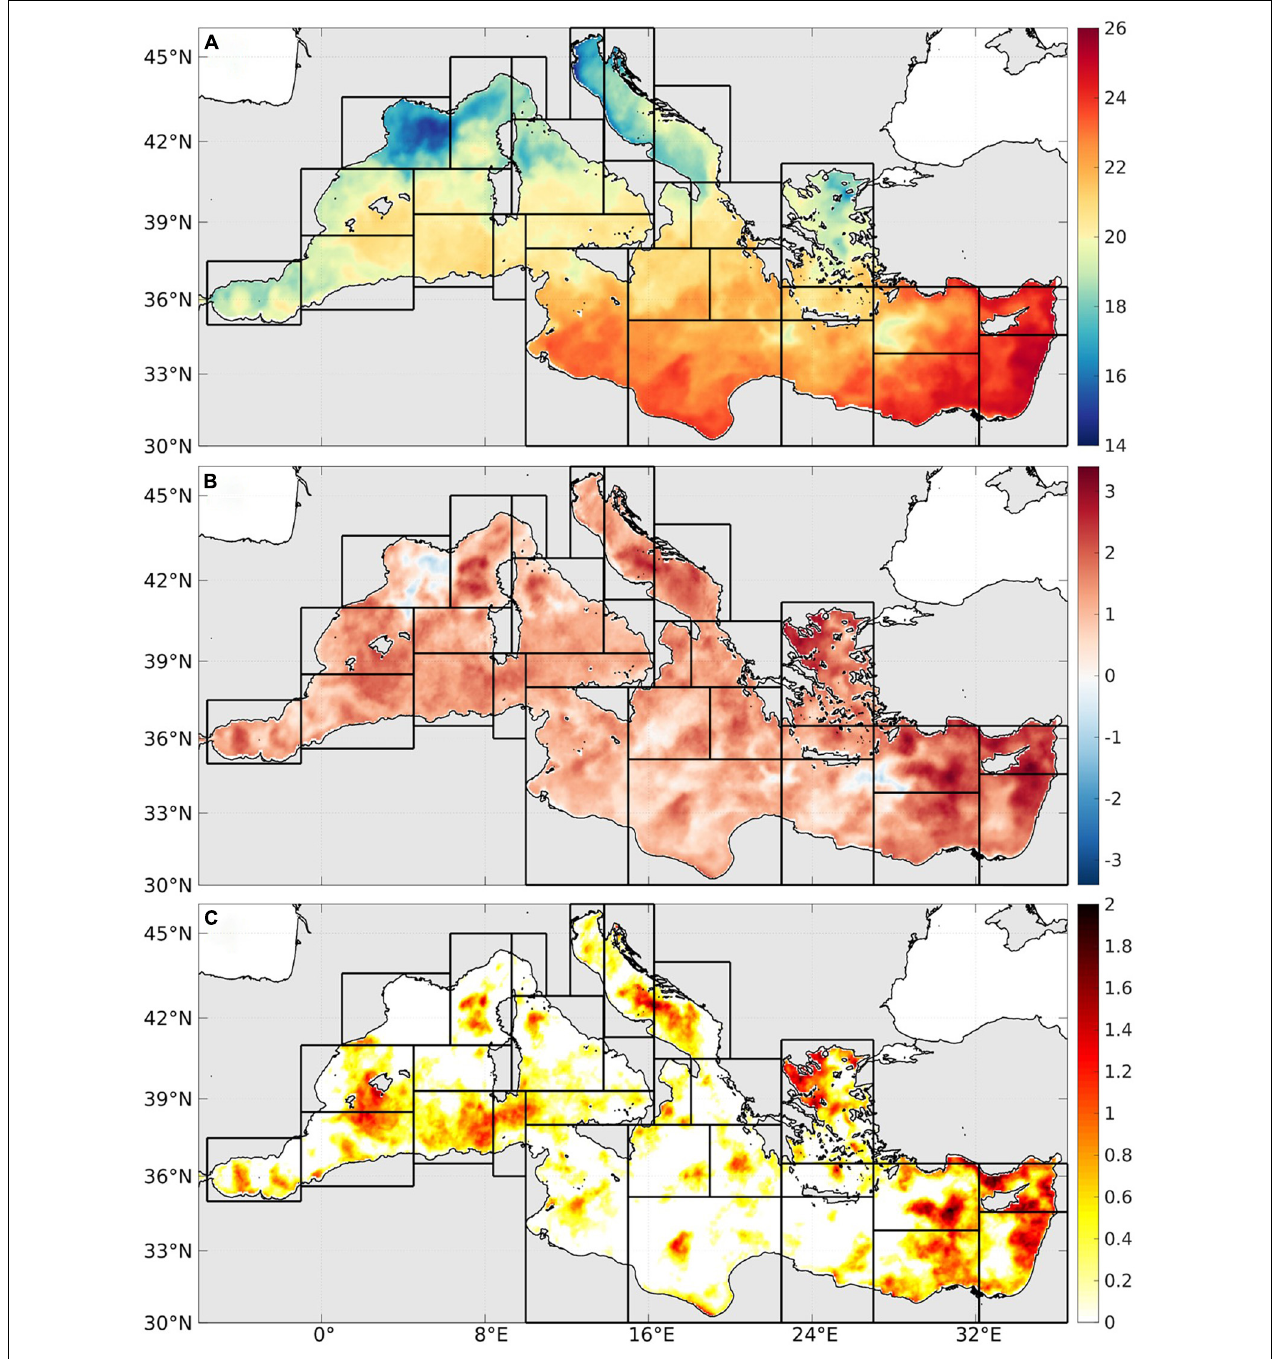
FIGURE 3 | Daily SST (A) , SSTA (B) , and MHS (C) in the Mediterranean Sea (in ◦ C). Illustration on November 17, 2020.